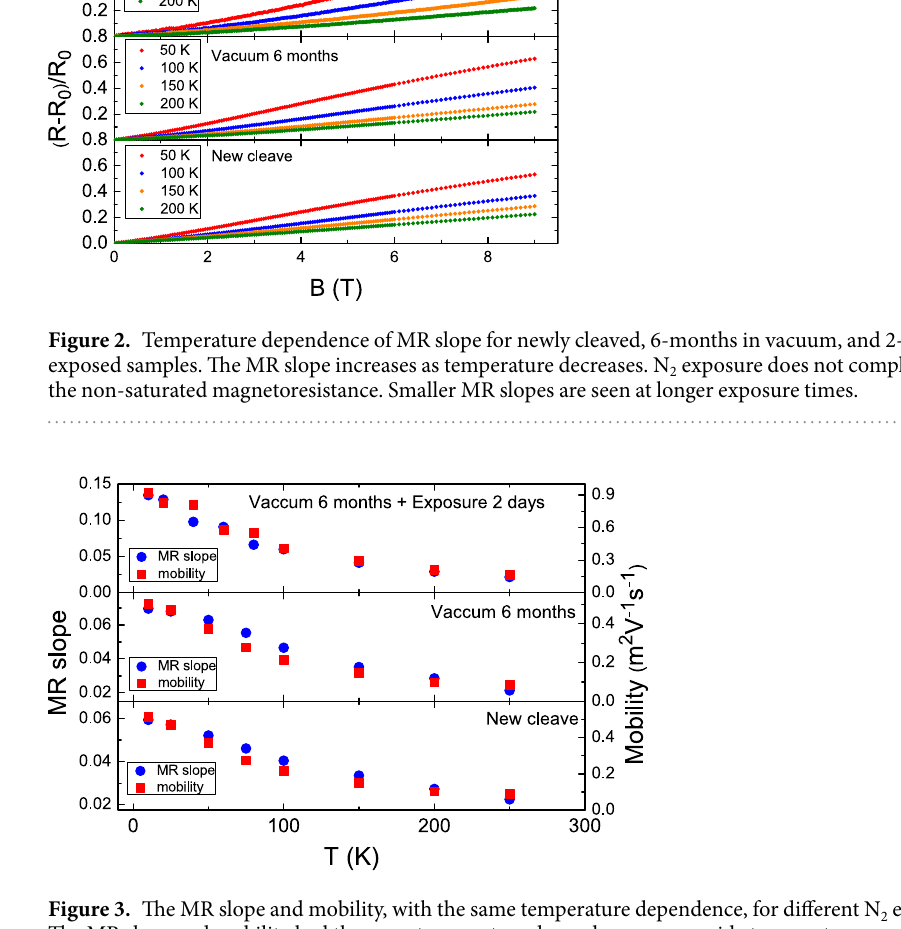
Figure 3. The MR slope and mobility, with the same temperature dependence, for different N 2 exposure times. The MR slope and mobility had the same temperature dependence over a wide temperature range for different levels of N 2 exposure. The MR slope and mobility increased approximately 100% after 2-days N 2